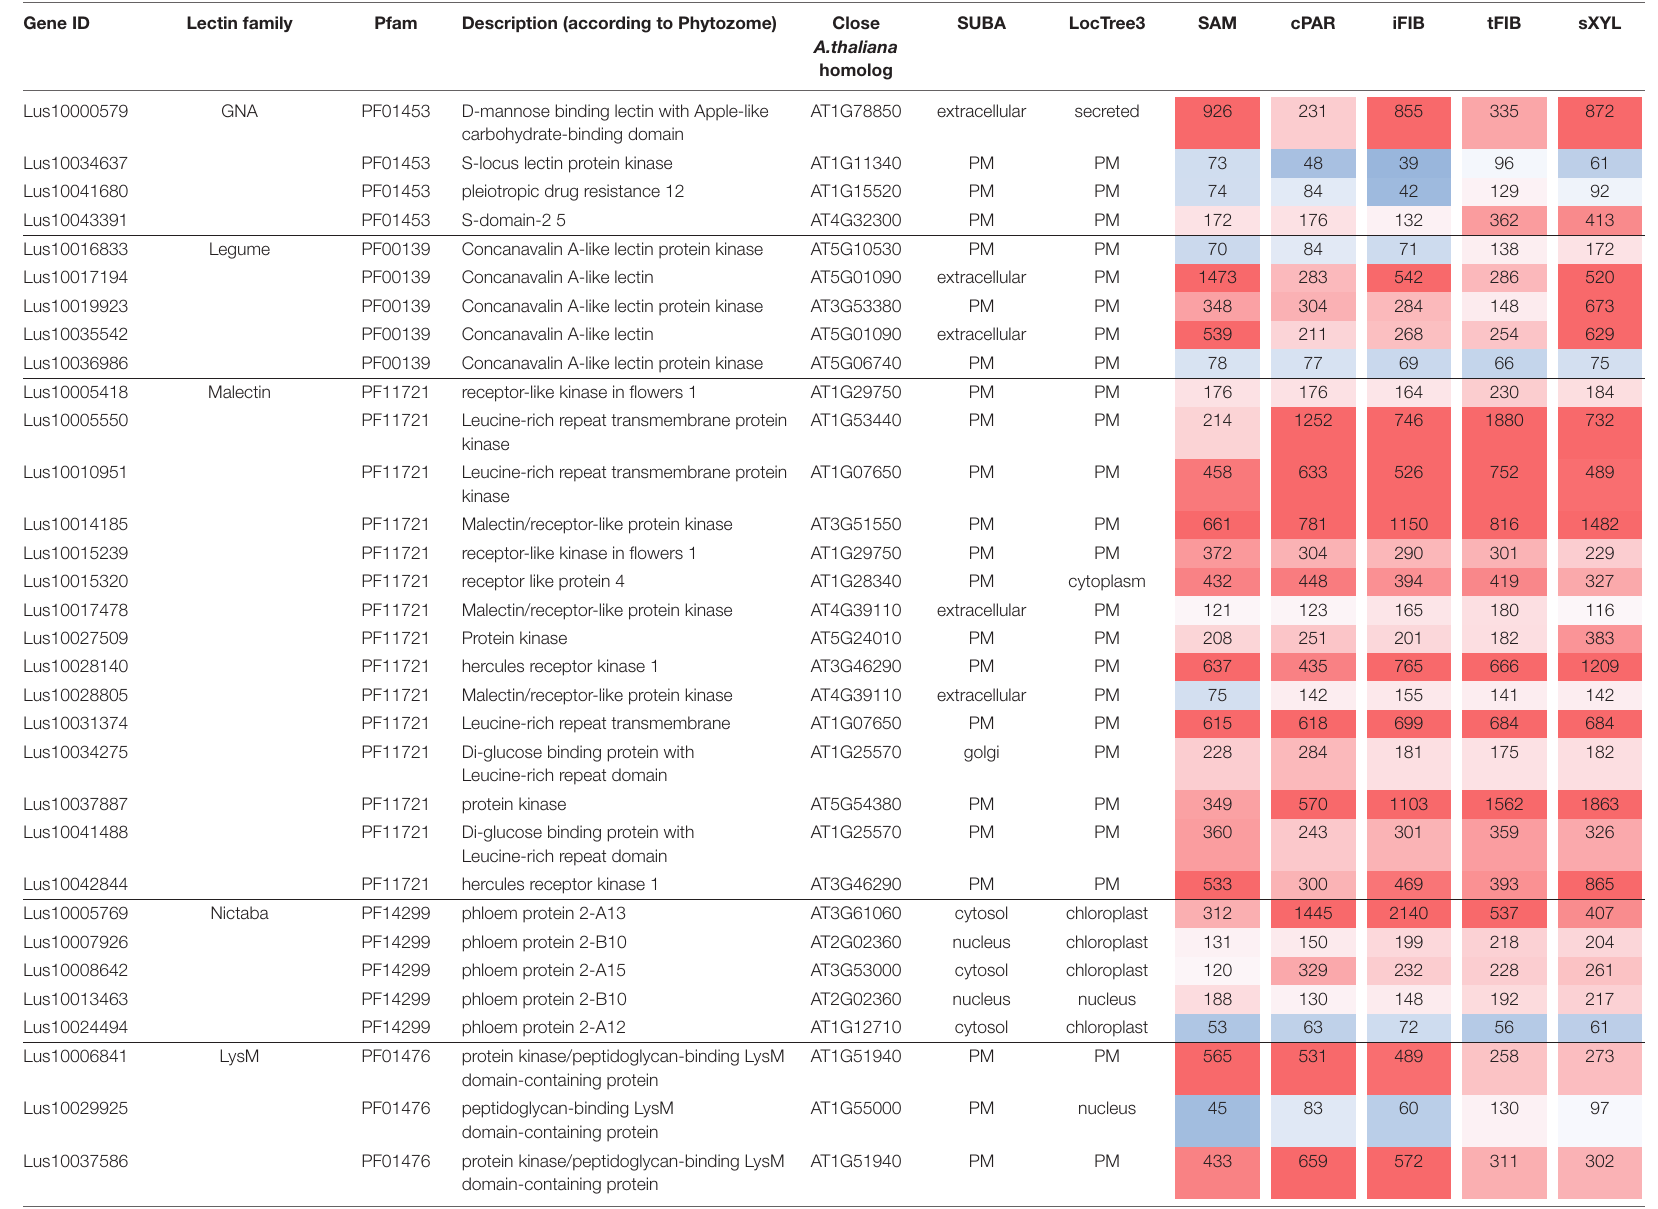
TABLE 2 | Linum usitatissimum genes encoding proteins with lectin domains with relatively constant expression values (the mean values of tau-score < 0.15 across all samples). Gene